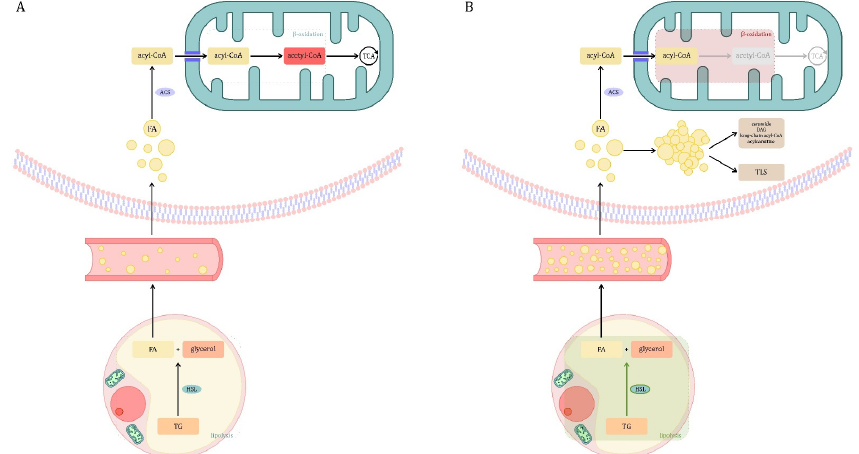
Figure 4. Lipid metabolism. ( A ) Physiological conditions. Triglycerides (TG) stored in adipocytes must undergo a three-step process by which other tissues can access their stored energy reserves. The first step, lipid mobilization, involves lipolysis of TG to fatty acids (FA) and glycerol, which diffuse into the plasma and are transported to the target tissues. TG is lipolyzed by the enzyme hormone-sensitive lipase (HSL). This process is influenced by many hormones. Insulin inhibits the action of HSL. Lipolysis-promoting hormones include catecholamines, glucagon, adrenocorticotropic hormone (ACTH), thyroid-stimulating hormone (TSH), growth hormone (GH) and vasopressin. Moreover, most lipolytic processes require the presence of thyroid hormones and glucocorticosteroids for optimal effect [114]. The second step is to activate FA and transport them to the mitochondria. The enzyme acyl-CoA synthase catalyzes the conversion of FA to active fatty acid (acyl-CoA). Then, long-chain acyl-CoA molecules penetrate the inner mitochondrial membrane as carnitine derivatives (acylcarnitine). The third step is β -oxidation—acyl-CoA molecules are broken down into acetyl-CoA, which can be oxidized in the tricarboxylic acid (TCA) cycle [115]. ( B ) Sepsis. In the initial stage of sepsis, lipolysis in adipose tissue is upregulated. The role of hormone-sensitive lipase (HSL) activation under the influence of LPS and prolipolytic hormones is suggested. Insulin resistance also contributes to the activation of lipolysis. Patients with sepsis have increased levels of fatty acids (FA) and triglycerides (TG) in the blood. This may be due to insulin resistance in the liver and adipose tissue. In the course of sepsis, the β -oxidation process is disturbed, which may be associated with a decrease in the expression of genes belonging to the PPAR- α signaling pathway. Additionally, the transport of long-chain FA to the mitochondria may be impaired due to possible accumulation of malonyl-CoA generated from glucose in hepatocytes. The lower efficiency of β -oxidation can cause energy deficiency, lipotoxicity and mitochondrial dysfunction, leading to organ damage. Lipotoxicity is a pathological metabolic phenomenon resulting from the accumulation of lipid intermediates in tissue other than adipose tissue. Lipid accumulation may lead to some of their metabolites (e.g., diacylglycerol (DAG), ceramide) reaching levels potentially harmful to cells. It is believed that excess lipids can be diverted to non-oxidative pathways and be transformed into toxic lipid species (TLS), which can damage mitochondria, modify cell signaling and increase apoptosis (lipoapoptosis). Legend: gray color—inefficient cellular processes; green color—increasing the activity of the process or enzyme; red color—lowering the activity of the process or